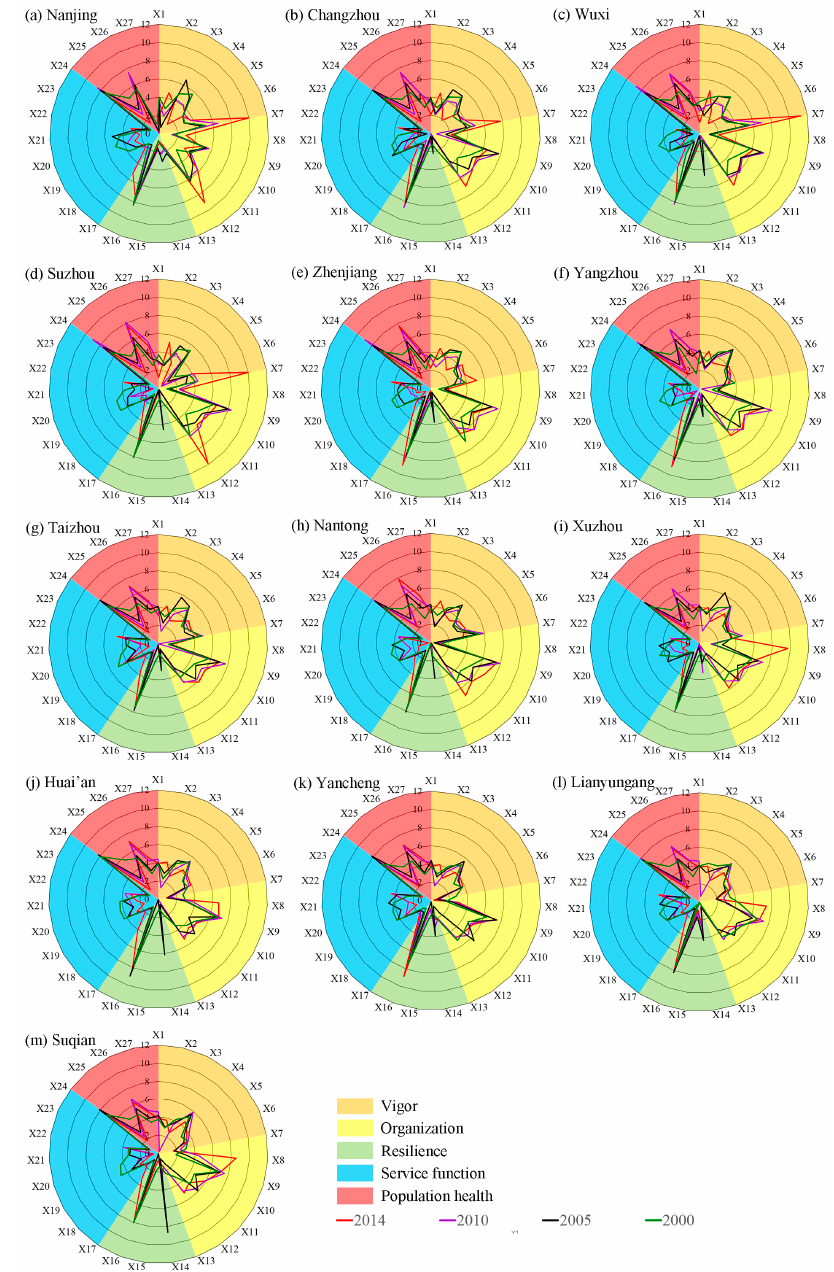
Figure 5. Obstacle degree of each indicator in different city from 2000 to 2014 (Different background colors represents different components of urban ecosystem health, lines with different colors represents obstacle degree values of each indicators with different years).